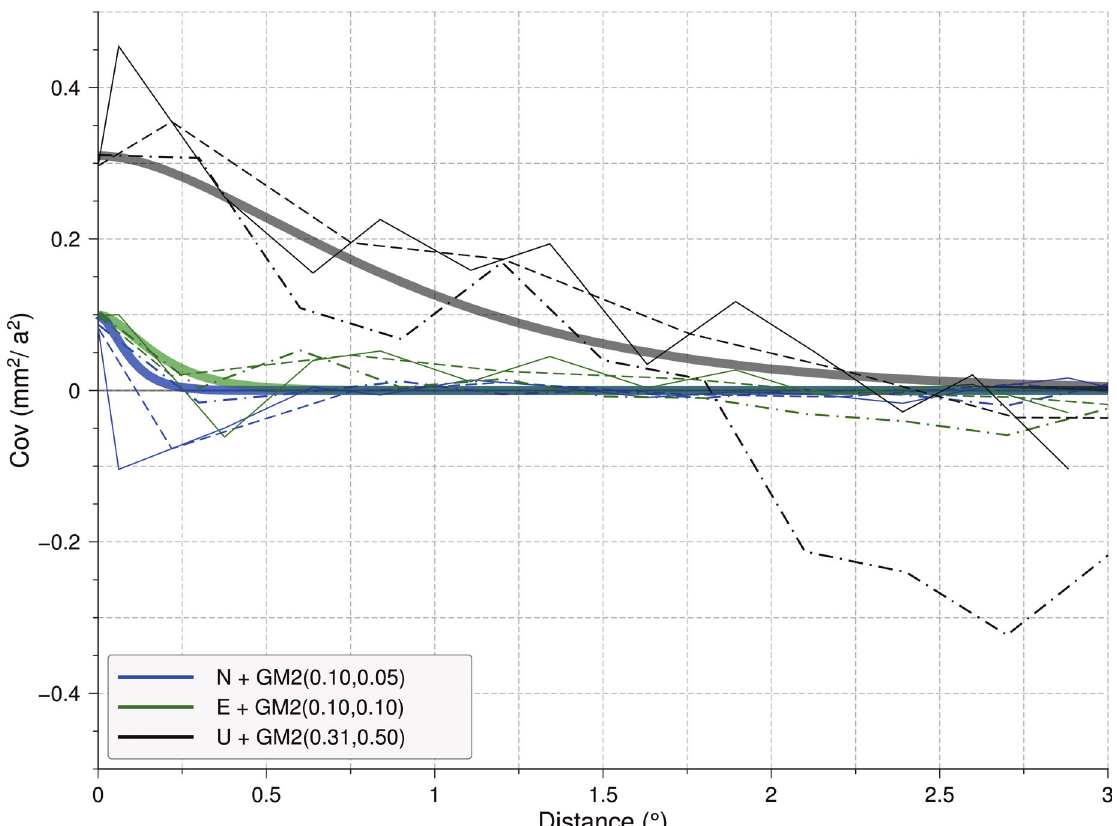
Fig. 8. The empirical and modelled autocovariance estimated for the residual 3D velocity components N, E, U of the 1st-order GRN points and CORS in Estonia. Different empirical curves were estimated by using different interval width dl values from 0.25° to 0.5° and software (gstat, cov_func_comp). The isotropic Gauss–Markov 2nd-order model (GM2) Cov = C ( l ) as a function of interval l between points with two unknown parameters was fitted with empirical curves; see text for more